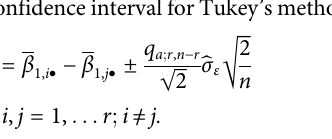
FIGURE6| R 2 coef fi cient fi tsofeachskillindicatormetricareplottedper window span. The averages of these values are presented in the inset table. The objective outcome metric, FR , best accounted for the process metrics used in the study to measure